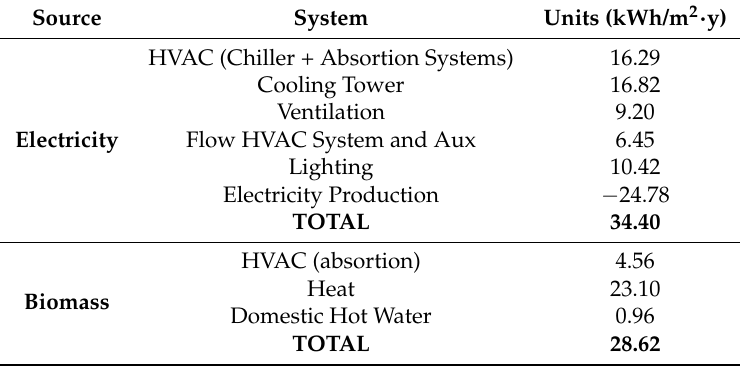
Table 2. Energy use, delivered electricity generation and biomass energy of different systems at LUCIA nZEB per